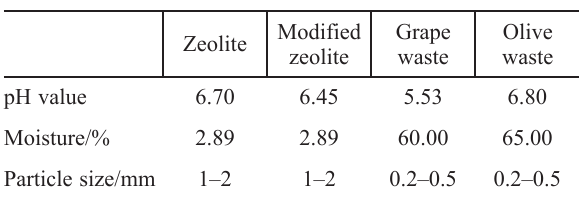
Table 1 – Physical characteristics of adsorbents